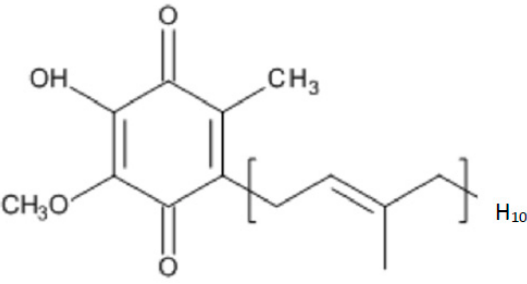
Figure 1. The chemical structure of CoQ 10 .